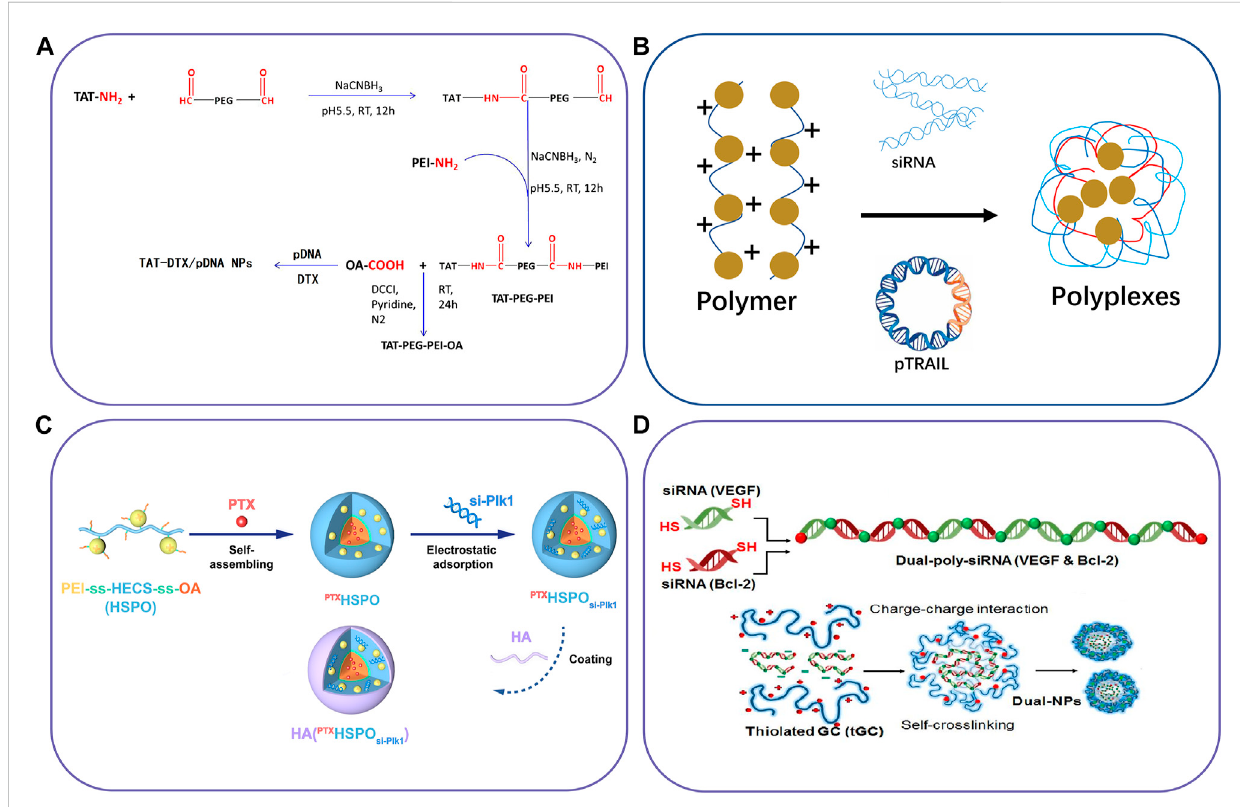
FIGURE 3 Schematic illustration of polymer-based nanocarriers to co-deliver two different agents. (A) The synthetic route of TAT-PEG-PEI-OA for co-deliver of DTX and pDNA, (B) lipopolymers to delivery pDNA and siRNA, (C) Chitosan derivatives for co-delivery of siRNA and PTX, and (D) Thiolated glycol chitosan for co-delivery of Dual-poly-siRNA. Reproduced with permission from ref. (Dong et al., 2016), (Thapa et al., 2019), (Yin et al., 2020), (Lee et al., 2015). Copyright 2016, 2019, 2020 and 2015, Elsevier, Mary Ann Liebert, American Chemical Society, and Elsevier, respectively.